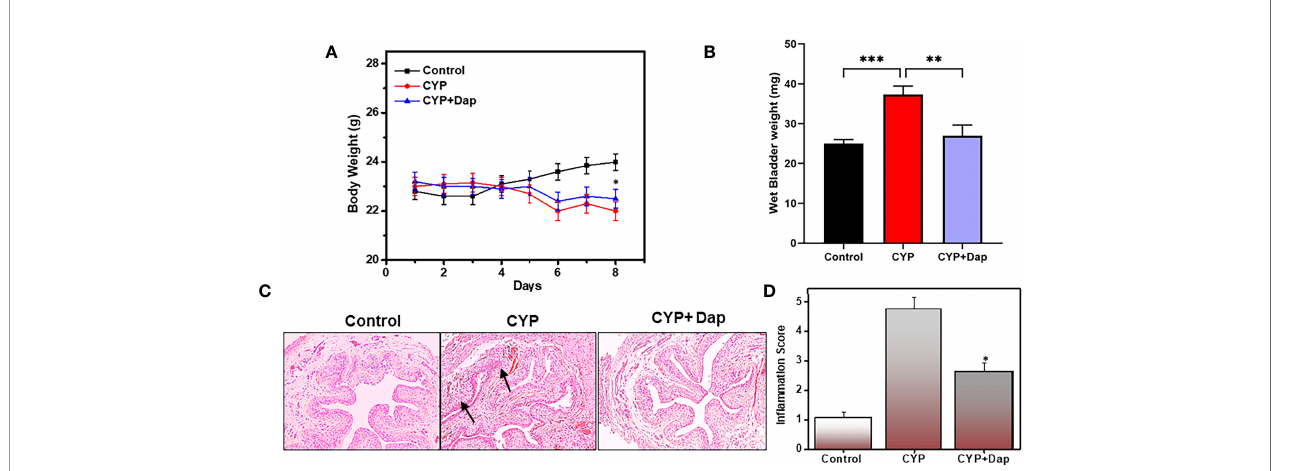
FIGURE 1 | Changes in body weight, bladder weight, in fl ammation score, and urinary bladder (UB) histology after Dap treatment during CYP-induced IC. C57BL/6 control mice ( ▪ ) received normal water, ( (cid:129) ) received CYP+vehicle, and ( ▴ ) received CYP+Dap (100 mg/kg body weight of dapansutrile every alternate day beginning at day two, while both CYP+vehicle and CYP+Dap groups received CYP continually every alternate day beginning at day one until day eight. The body weight of the mice was recorded every day, and any body weight changes are expressed in (A) Mice were sacri fi ced after eight days and the wet bladder weights of the three groups of mice are presented in (B) Histological sections of UBs from the three groups of mice are shown in (C) Mice that received CYP+vehicle showed cellular in fi ltration and reduced lumen space as compared to control mice (C ; arrow ) , while mice that received CYP+Dap showed signi fi cantly reduced cellular in fi ltrations and lower in fl ammation scores (D) . All data represent the mean value ± SEM from three independent experiments involving six mice per group (n=18). Asterisks indicate statistically signi fi cant differences between CYP+vehicle- and CYP+Dap-treated groups (*p<0.05 and **p<0.01) or statistically signi fi cant differences between control and CYP induced wet bladder weight